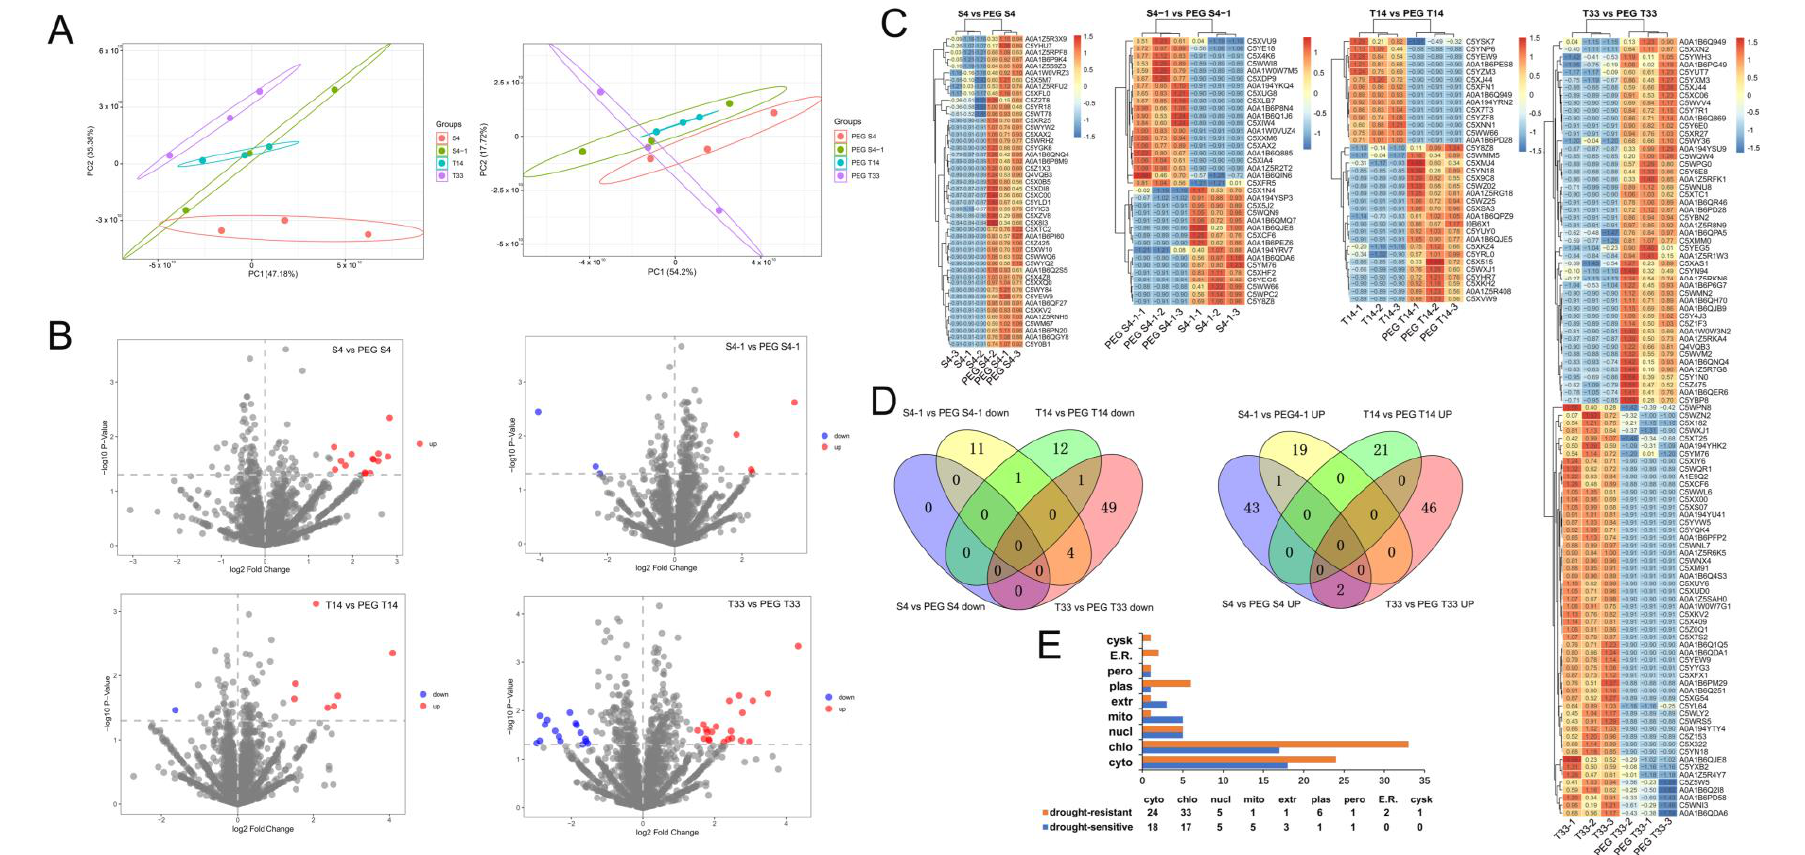
Figure 3. The bioinformatic analysis of DAPs in drought-sensitive (S4 and S4-1) and drought resistant (T14 and T33) sorghums. PCA plots from the full proteome of control and PEG-treated groups following PEG-simulated drought for 24 h ( A ). Volcano plots showing the DAPs of consensus proteins in S4, S4-1, T14, and T33 under drought stress ( B ). Heat maps displaying the log2 FC in abundance for DAPs significantly affected by drought stress. Each lane shows the mean of a biological replicate, and the analysis was performed in triplicate ( C ). Venn diagram showing the overlap in the numbers of the upregulated and downregulated proteins ( D ). Subcellular location analysis of DAPs of drought-sensitive and drought-resistant sorghums. Blue, yellow, green and red ovals represent up-or down-regulated proteins of S4 vs. PEG S4, S4-1 vs. PEG S4-1, T14 vs. PEG T14 and T33 vs. PEG T33, respectively. ( E ). cyto: cytoplasm; chlo: chloroplast; nucl: nucleus; mito: mitochondria; extr: extracellular; plas: plasma membrane; pero: peroxisome; E.R.: endoplasmic reticulum; cysk: cytoskeleton.